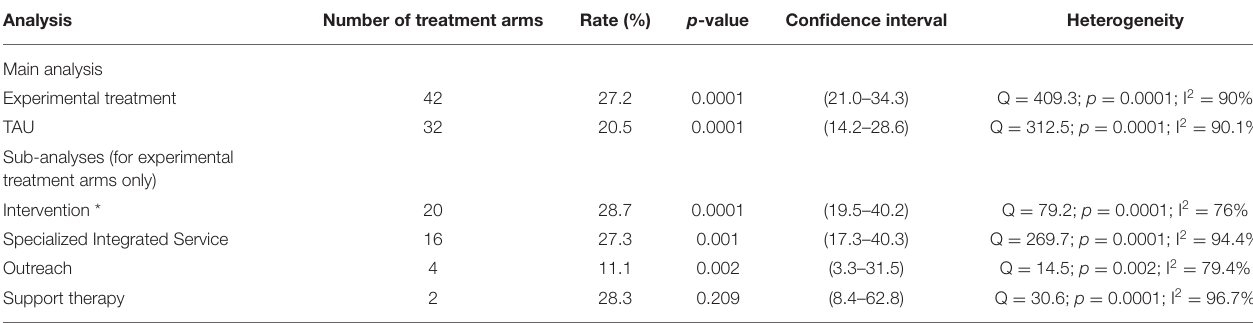
TABLE 2 | Primary and secondary analyses: drop-out rates across interventions.